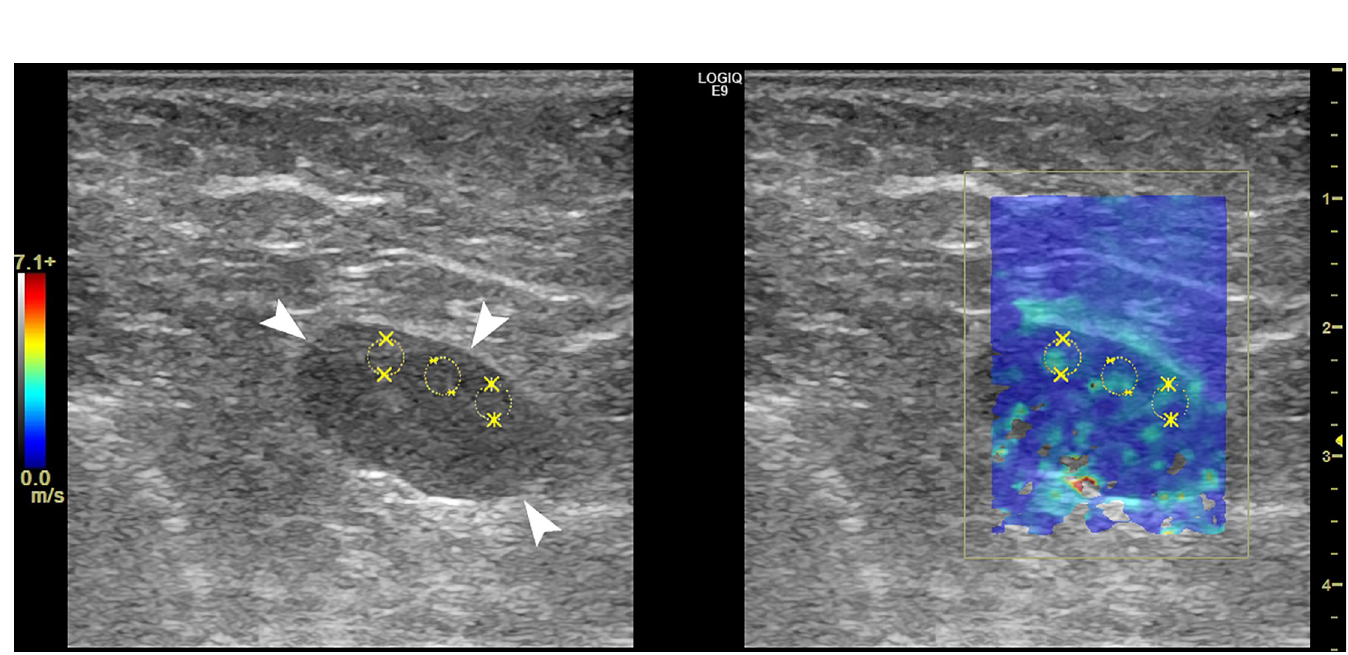
Fig 5. Left axillary B-mode (left) and shear wave speed map (right) images in a 60-year-old woman with a left breast mass and left axillary adenopathy identified on cardiac MRI. The US image shows an enlarged lymph node (white arrows) with a cortical thickness of 10.6-mm and absent hilum. The elasticity results calculated from the average of the 3 ROIs (yellow) were E mean = 6.6-kPa and E max = 20.1-kPa. FNA biopsy results showed a mixed lymphoid population consistent with a reactive intraparenchymal lymph node. Core needle biopsy of the breast mass resulted in a diagnosis of fibroadenoma with usual ductal hyperplasia.